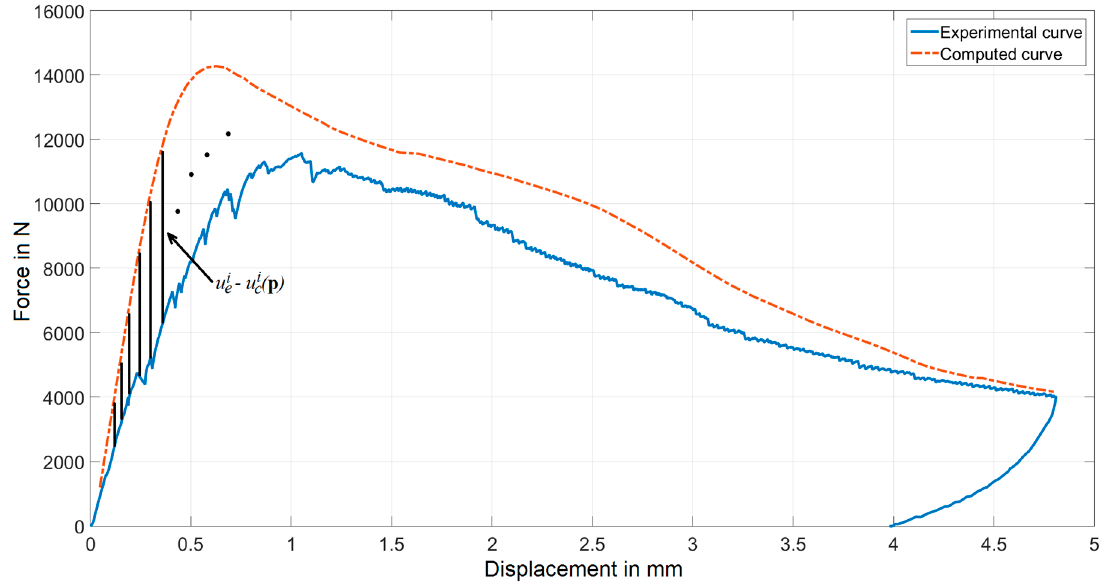
Figure 6. Construction of the discrepancy function from the force-displacement curve.